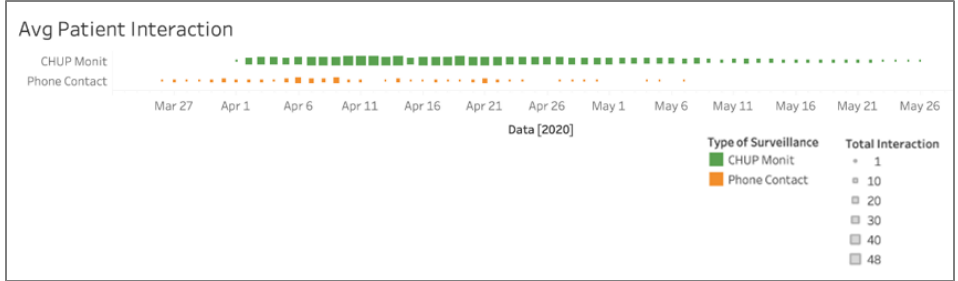
Figure 11. Continuity of interaction using different channels.